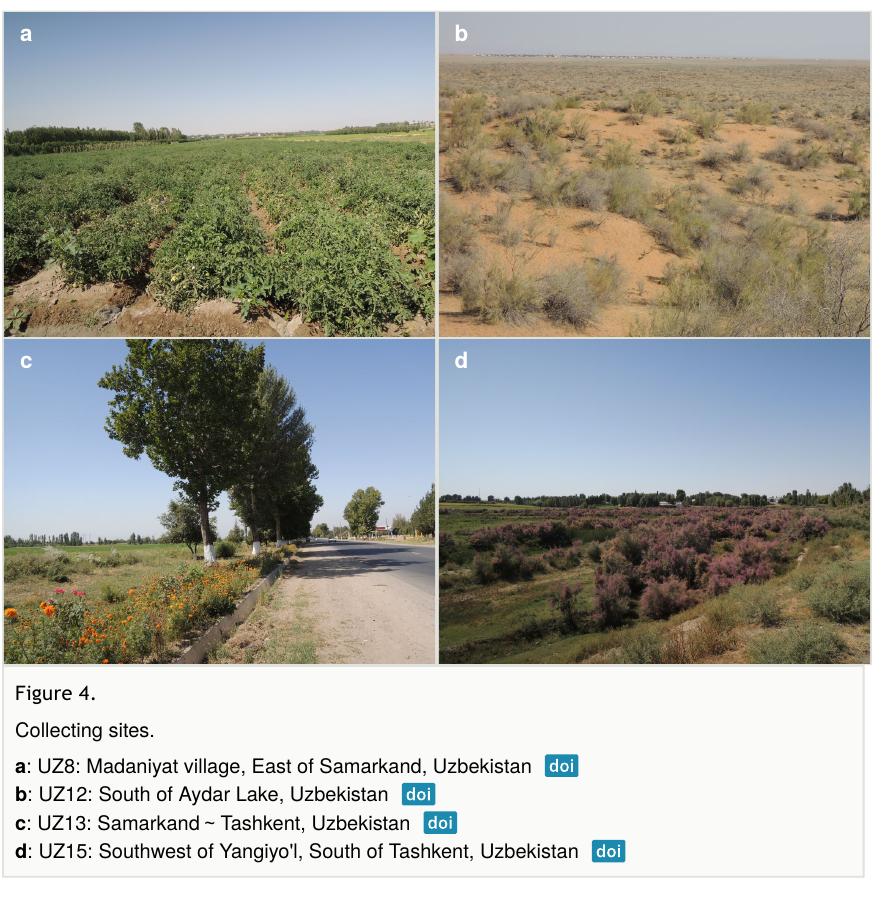
Uzbekistan UZ1: Aydar Lake, 28. viii. 2012 (Fig. 3d) UZ2: Botanical Garden, Tashkent, 1–4. ix. 2012 UZ3: Dalla Hovli, Northeast of Chirchik, 2. ix. 2012 (Fig. 3e) UZ4: Dalla Hovli, West of Parkent, 1. ix. 2012 UZ5: Gijduvon, North of Bukhara, 28. viii. 2012 UZ6: Golbog, West of Parkent, 1. ix. 2012 UZ7: Gushrabot, South of Aydar Lake, 29. viii. 2012 (Fig. 3f) UZ8: Madaniyat village, East of Samarkand, 31. viii. 2012 (Fig. 4a) UZ9: Nurota, South of Aydar Lake, 29. viii. 2012